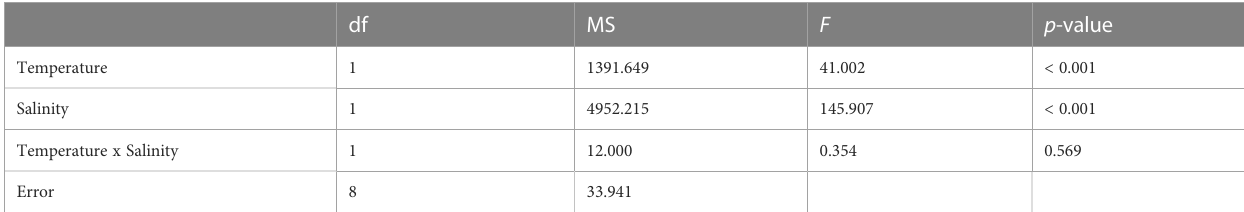
TABLE 1 Results of two-way ANOVA on differences in mean settlement (%) of Acropora pruinosa larvae under different temperature (27 and 32°C) and salinity (33 and 26 psu) treatments.